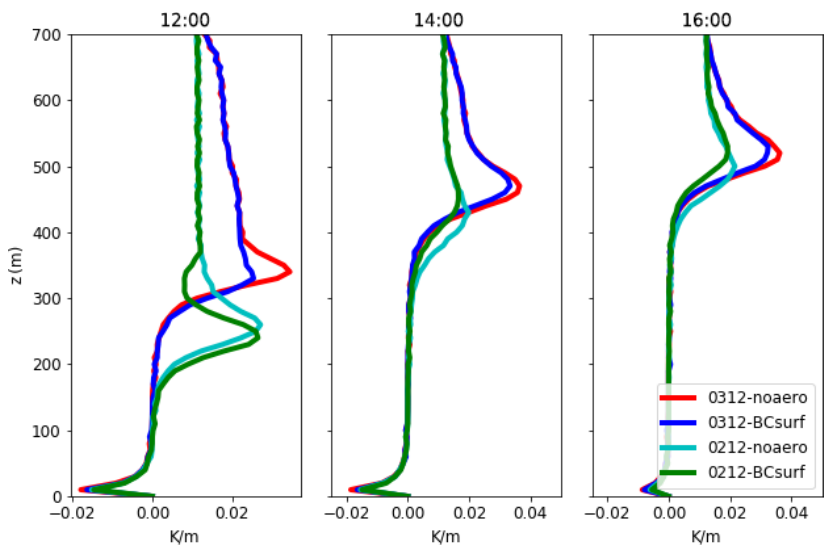
Figure 9. Potential temperature lapse rate at 12:00, 14:00 and 16:00 for simulations with surface aerosols (blue and green) and no aerosols (red and cyan) on 2 December (cyan and green) and 3 December (red and